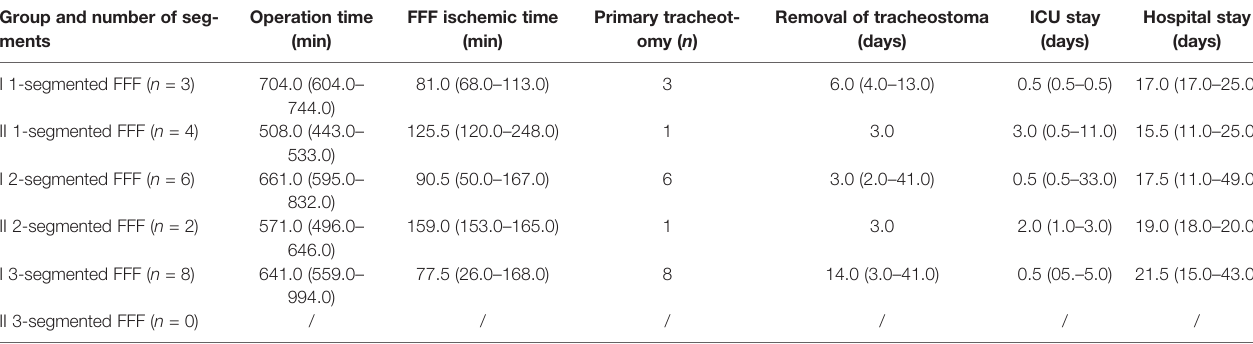
TABLE 4 | Comparison of mandibular reconstructions with the fi bula free fl ap in both groups: double fl ap (= I) versus temporal anastomosis (= II). Group and number of seg- ments